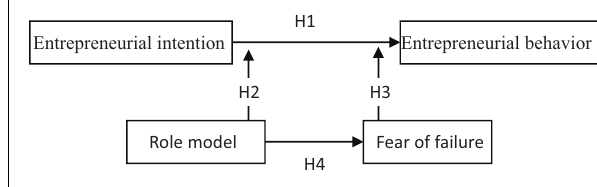
FIGURE 1 | Research